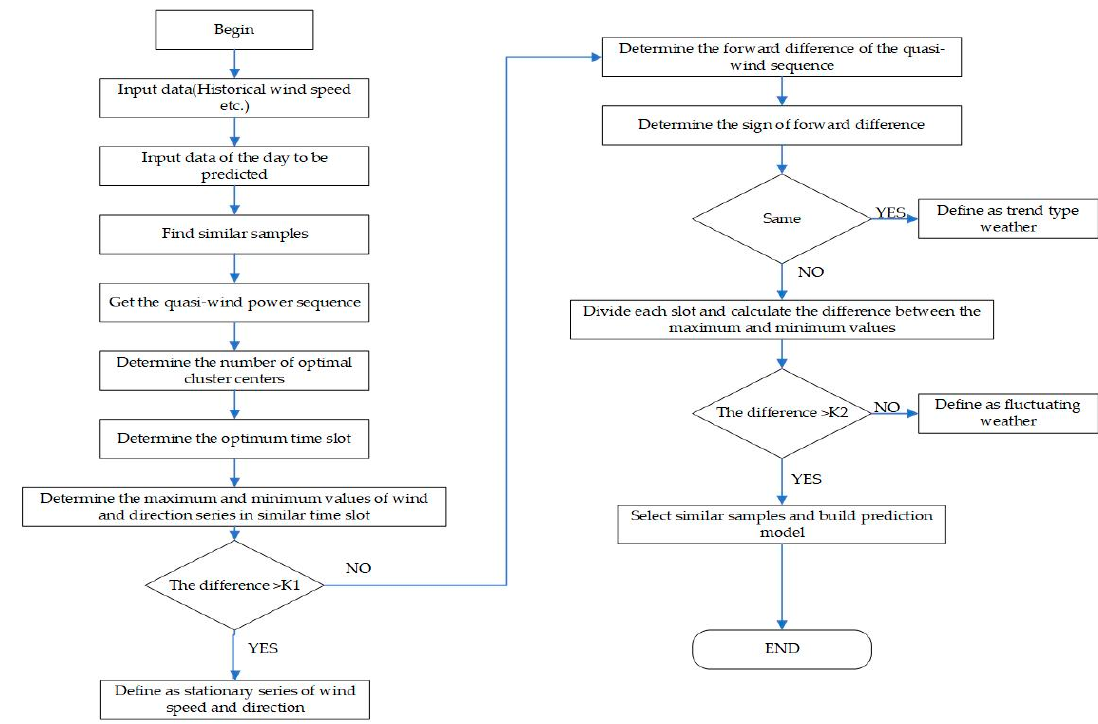
Figure 2. The process of partitioning continuous periods based on the wind characteristics.